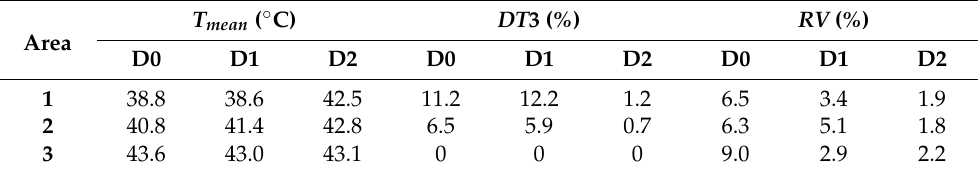
Table 4. Comparison of the heating performance of the three designs.